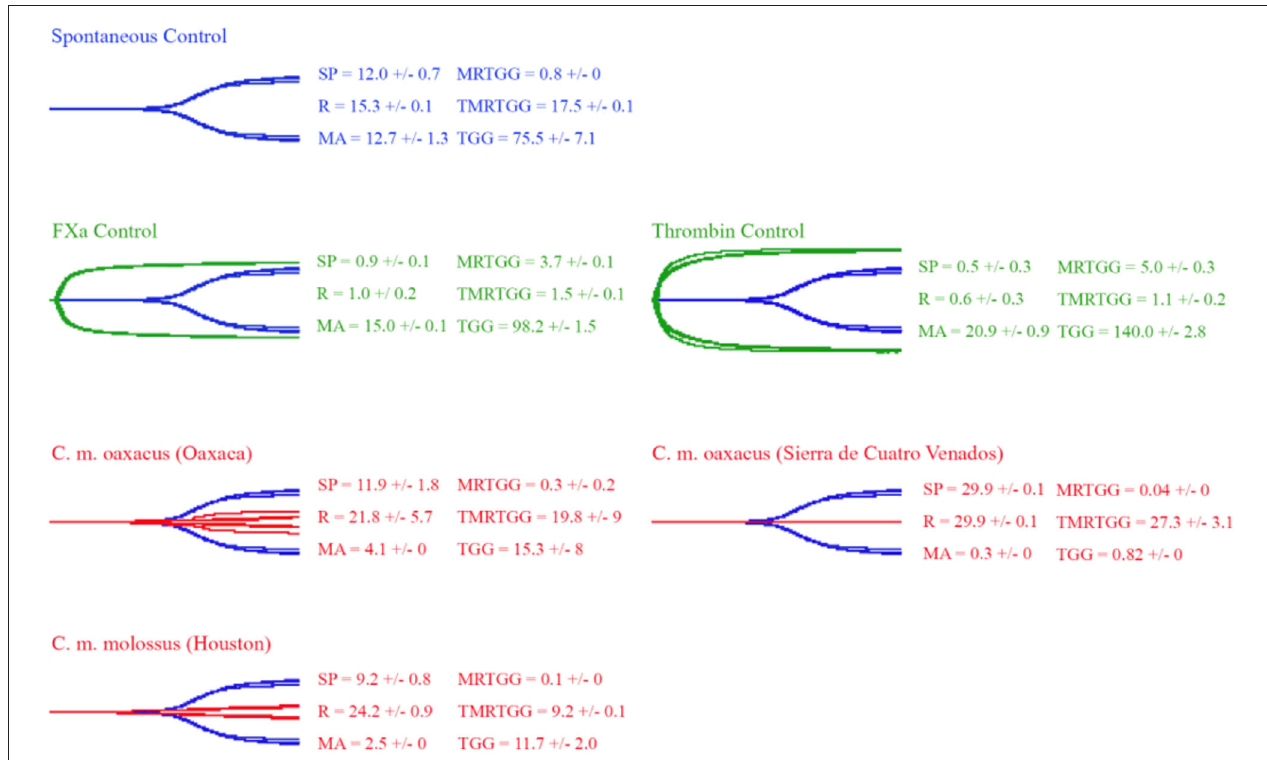
FIGURE 5 | Thromboelastography traces showing the coagulation pattern of human plasma incubated with venoms of three C. molossus specimens of two subspecies ( C. m. molossus and C. m. oaxacus ). Venom traces are shown in red, spontaneous clotting control traces in blue, thrombin and Fxa control traces in green. SP, split point (min); R, time (min) to minimum detectable clot (2mm); MA, maximum amplitude (mm); MRTGG, maximum rate of thrombus generation (dynes/cm 2 ); TMRTGG, time to maximum thrombus generation (min); TGG, total thrombus generation (dynes/cm 2 ). Results shown as n = 4 mean ±